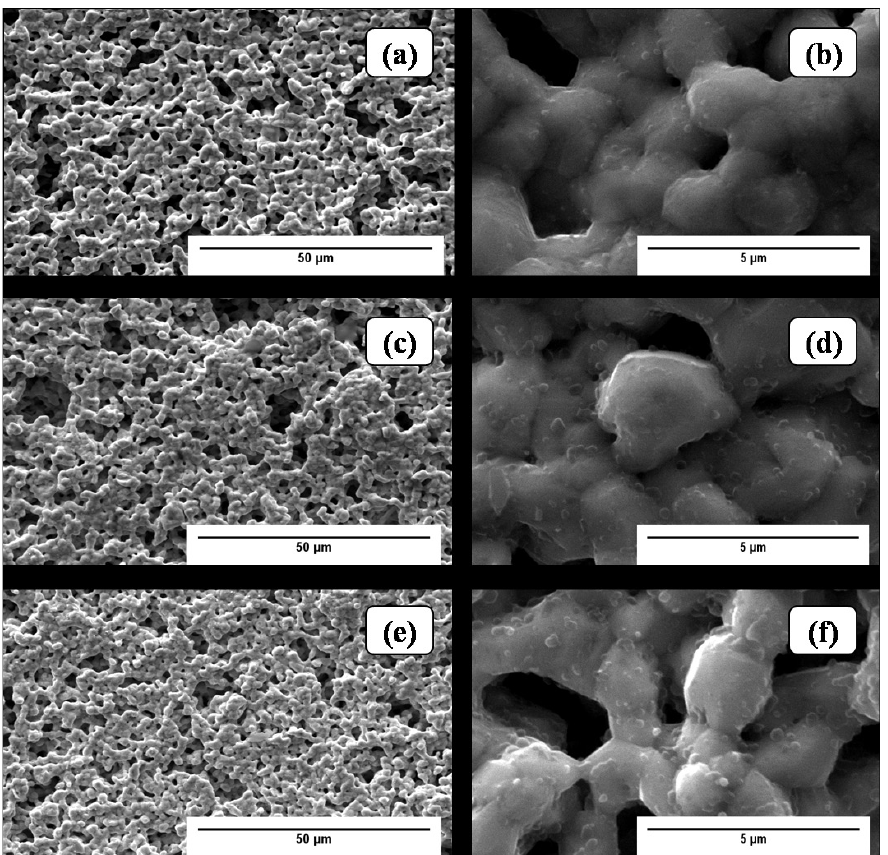
Figure 4: Microstructure of Ni-TiO